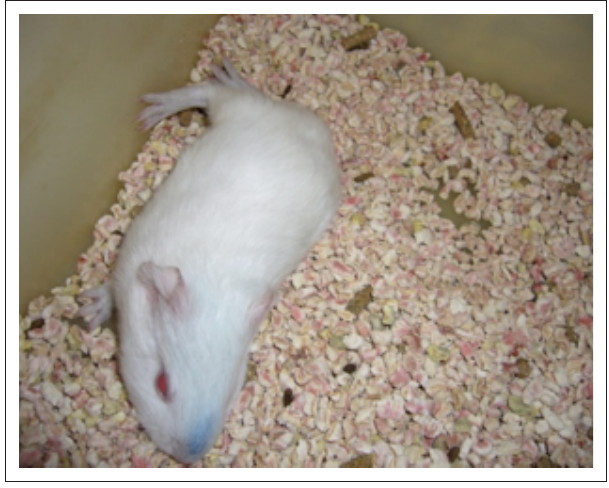
Source : Photographed by R.A. Schultz FIGURE 5: Guinea pig 24 h after dosing with diplonine, experiencing frequent falling (moderately affected).